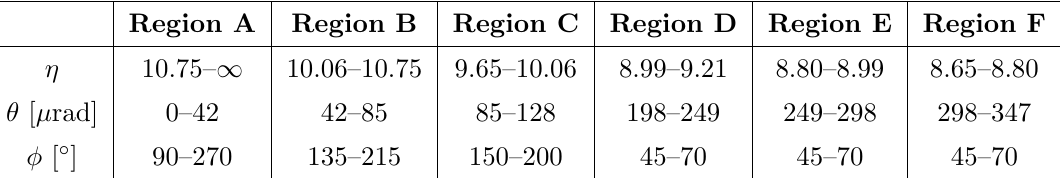
Table 1 . De(cid:12)nition of the six pseudorapidity regions used in the analysis: the coverage is expressed in terms of pseudorapidity (cid:17) , scattering angle (cid:18) and azimuthal angle (cid:30)